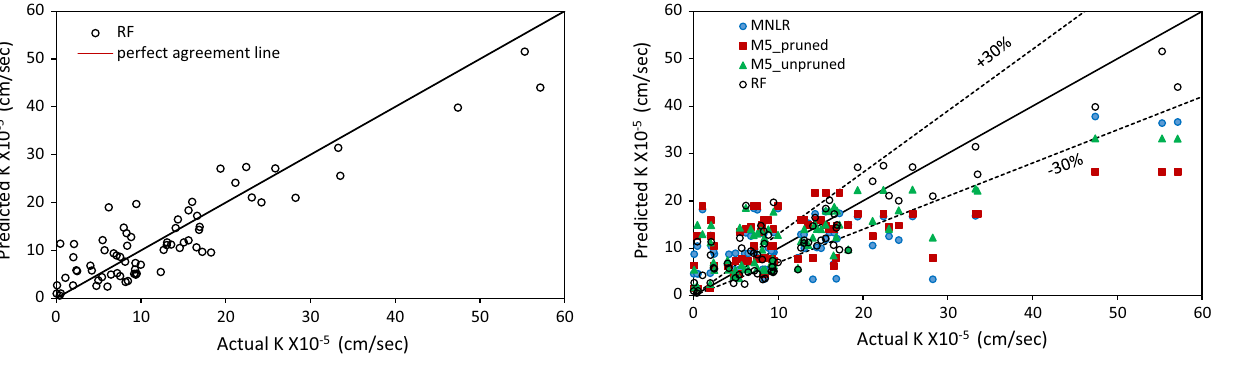
Fig. 6 Actual versus predicted values of hydraulic conductivity using RF model (testing data)